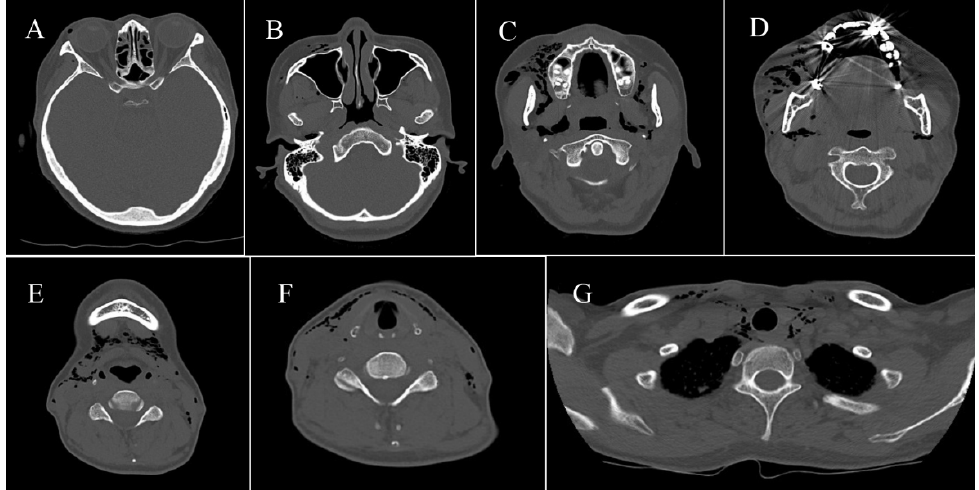
Figure 5. ( A , B ) There is little air in the orbital soft tissue and buccal space. ( C , D ) Air in the masticatory muscle space and the parotid gland space was slightly reduced. ( E – G ) Air in the submandibular space and the submental space, the mediastinum was significantly